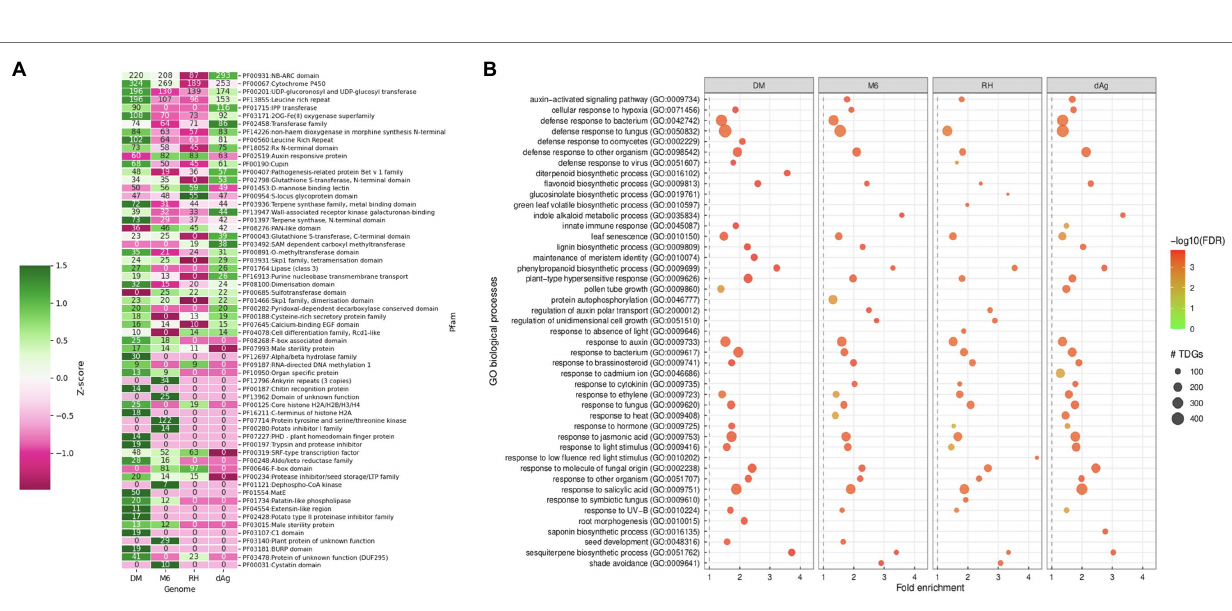
FIGURE 4 | (A) Enriched Pfam protein domains in tandemly duplicated genes which are under positive selection (i.e., K a / K s > 1) in DM, M6, RH, and dAg. (B) Top 30 GO biological processes enriched in tandemly duplicated genes which are under positive selection ( K a / K s > 1) in DM, M6, RH, and